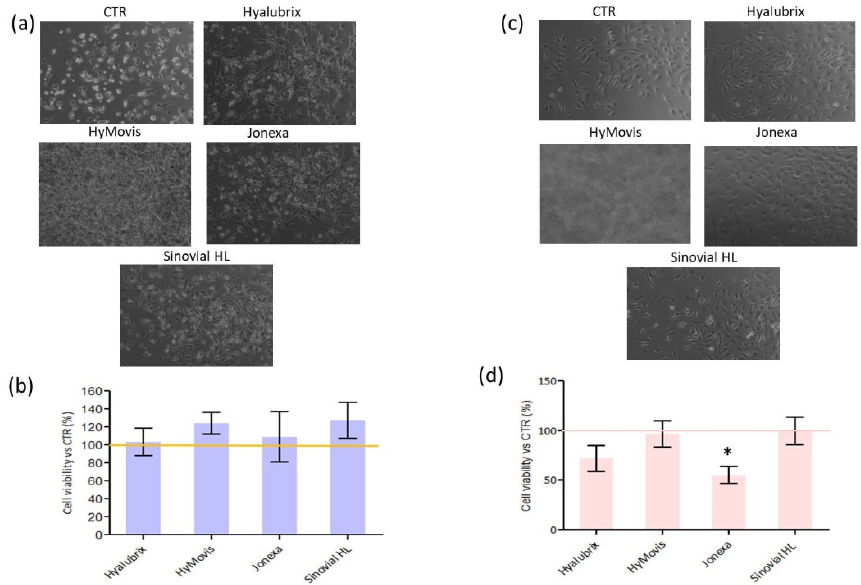
Figure 4. Cell image panels in the presence of different HA hydrogels were compared to untreated chondrocytes ( a ) and synoviocytes ( c ). Quantification of cell viability was performed using CCK8 staining for both chondrocytes ( b ) and synoviocytes ( d ).